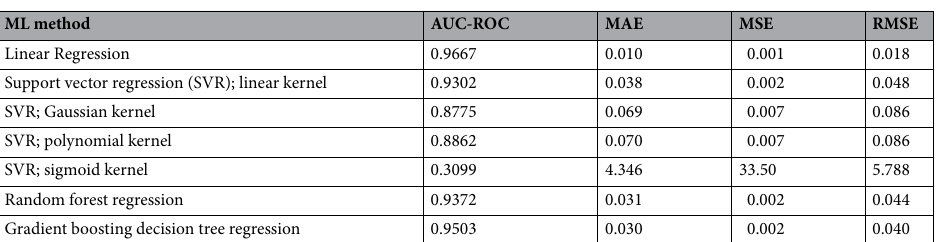
Table 4. The mean absolute error (MAE), mean square error (MSE), root mean square error (RMSE), and area under curve (AUC) of receiver operating characteristics (ROC) of the applied machine learning (ML) regression methods in predicting the grain yield per plant of the Lallemantia iberica ecotypes with the training of other traits, using the K-fold cross-validation as the data splitting method.